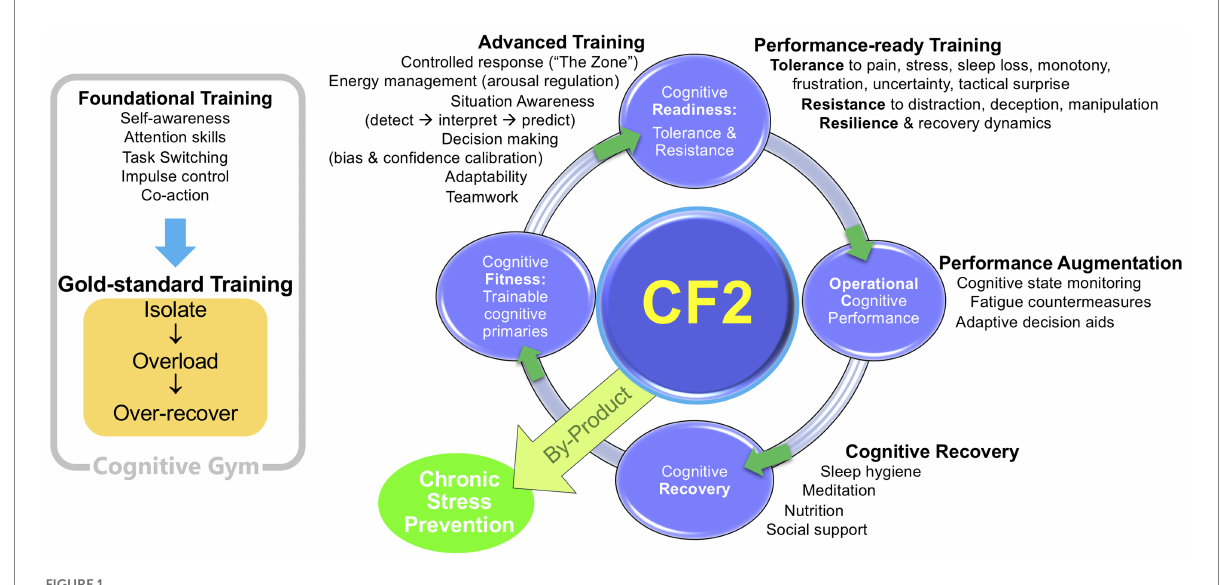
FIGURE 1 The Cognitive Fitness Framework (CF2; adapted from Aidman,